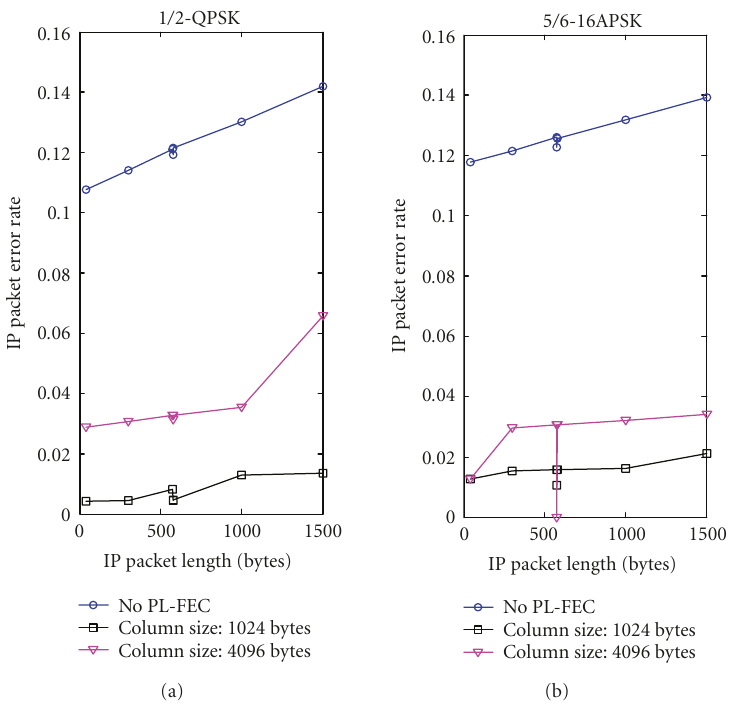
Figure 14: Dependence of the IP packet error rate with the IP packet size for two column sizes (1024 and 4096 bytes) and two MODCOD modes (1/2-QPSK and